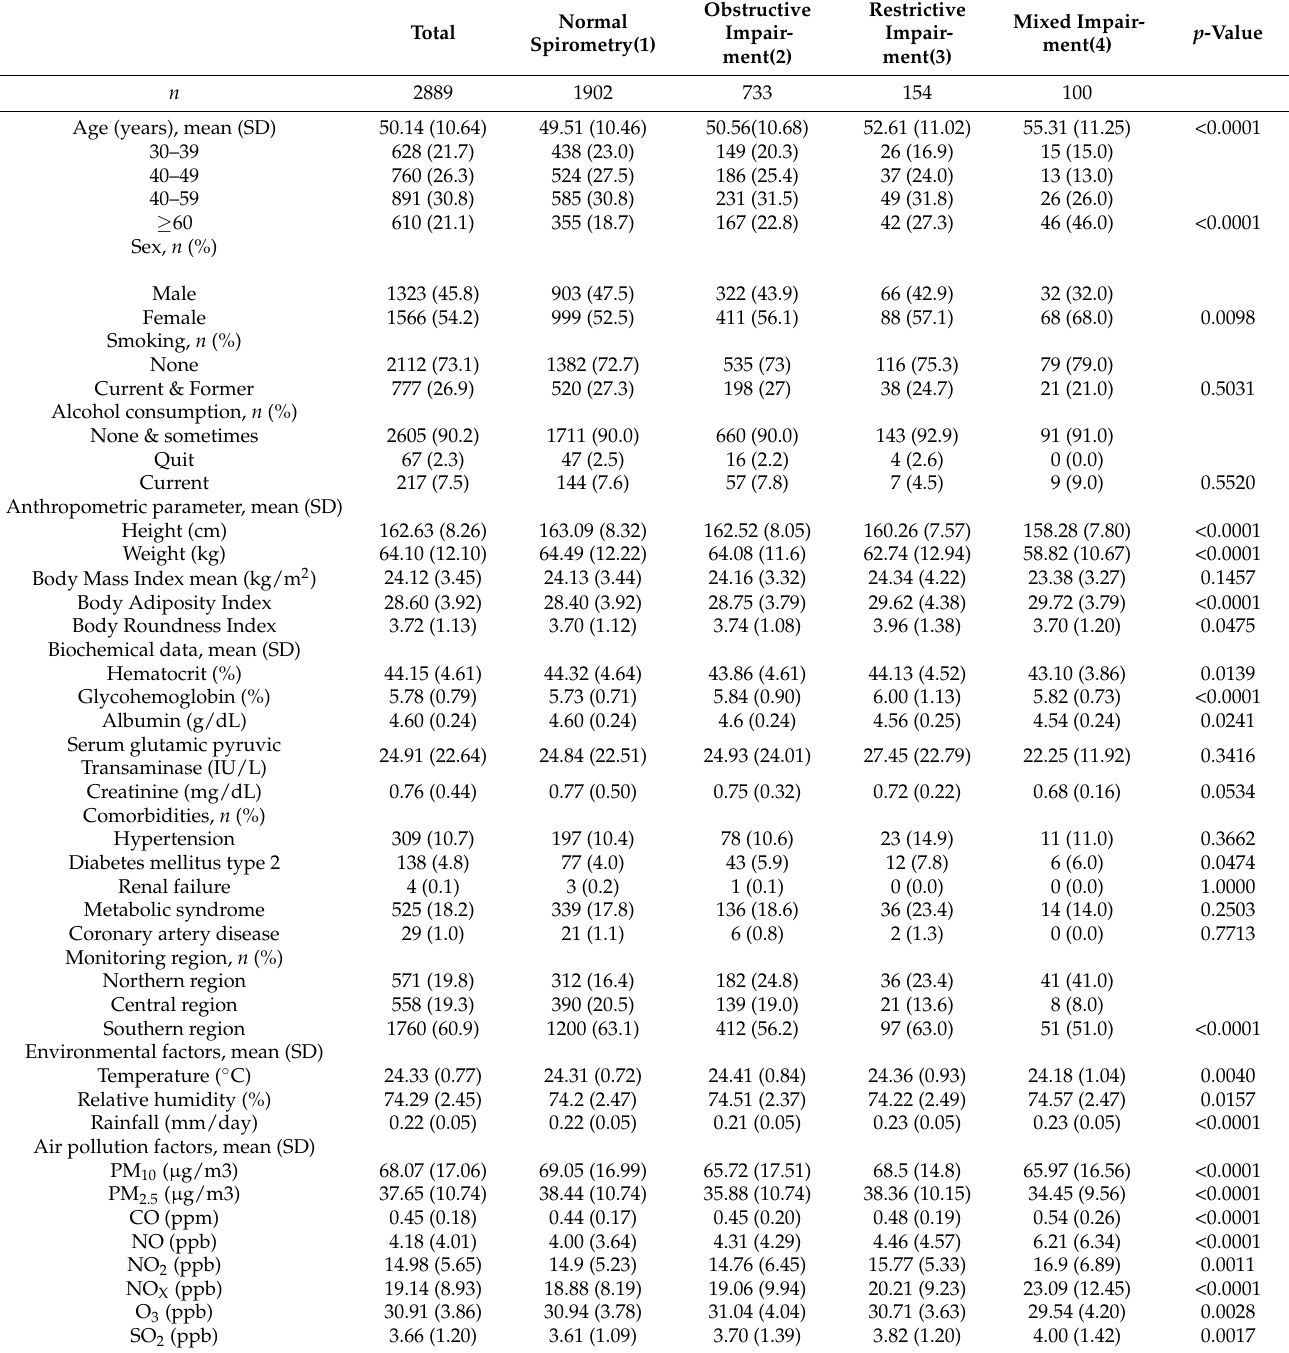
Table 1. Descriptive statistics of the demographic, laboratory, meteorological factors, and air